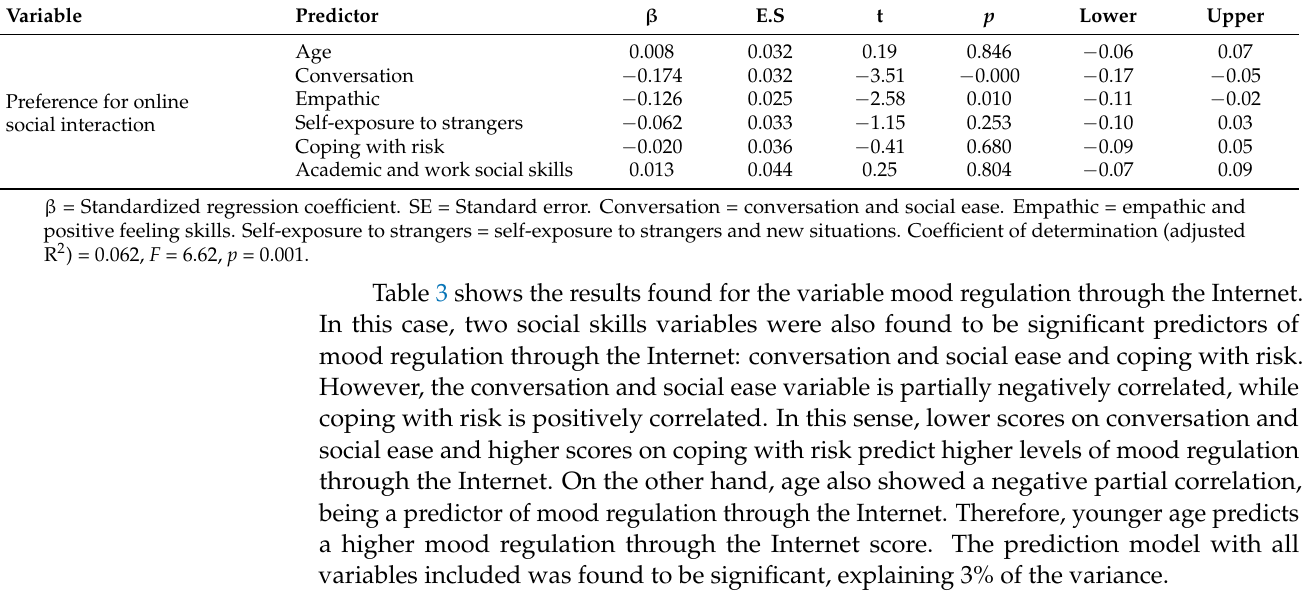
Table 3. Summary of the multiple linear regression model for mood regulation through the Internet variable in line with the predictor variables included in the